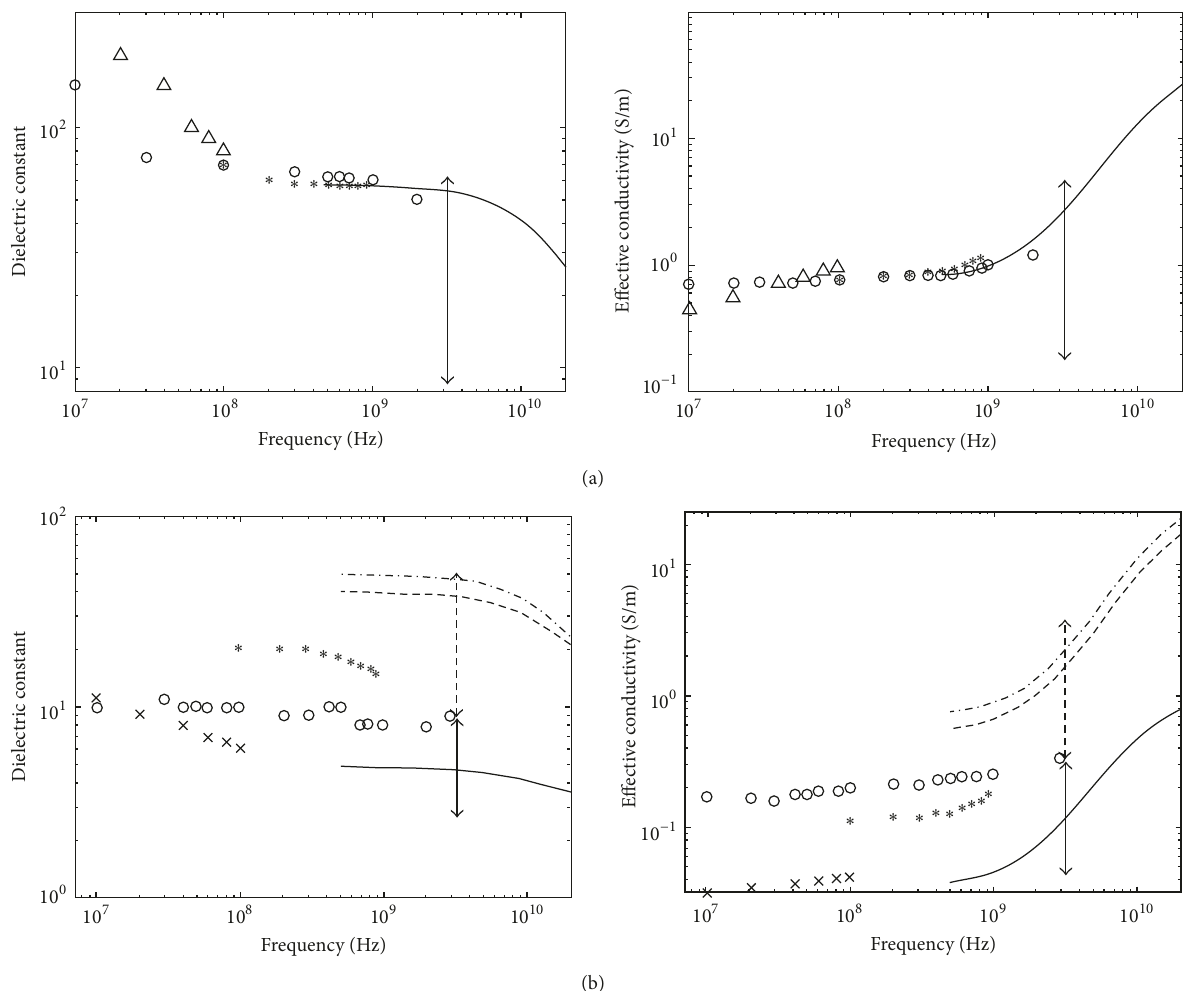
Figure 5: Comparison of malignant tissues and normal breast tissues dielectric properties of previous studies and from the Wisconsin University and Calgary University research team. (a) Malignant tissues properties; (b) normal breast tissues properties. Lines: median dielectric properties of the cancer samples from Wisconsin University and Calgary University research team (dash-dotline: group 1, 0–30% adipose, dashed line: group 2, 31–84% adipose, solid line: group 3, 85–100% adipose). Symbols: malignant breast tissue dielectric properties data published previously ( ∘ , Chaudhary et al. [11]; Δ , Surowiec et al. [12]; ∗ , Joines et al. [13]). Vertical arrows: range of data reported by Campbell and Land [14] at 3.2 GHz for malignant tissues [10, 15]. © Institute of Physics and Engineering in Medicine. Reproduced by permission of IOP Publishing. All rights